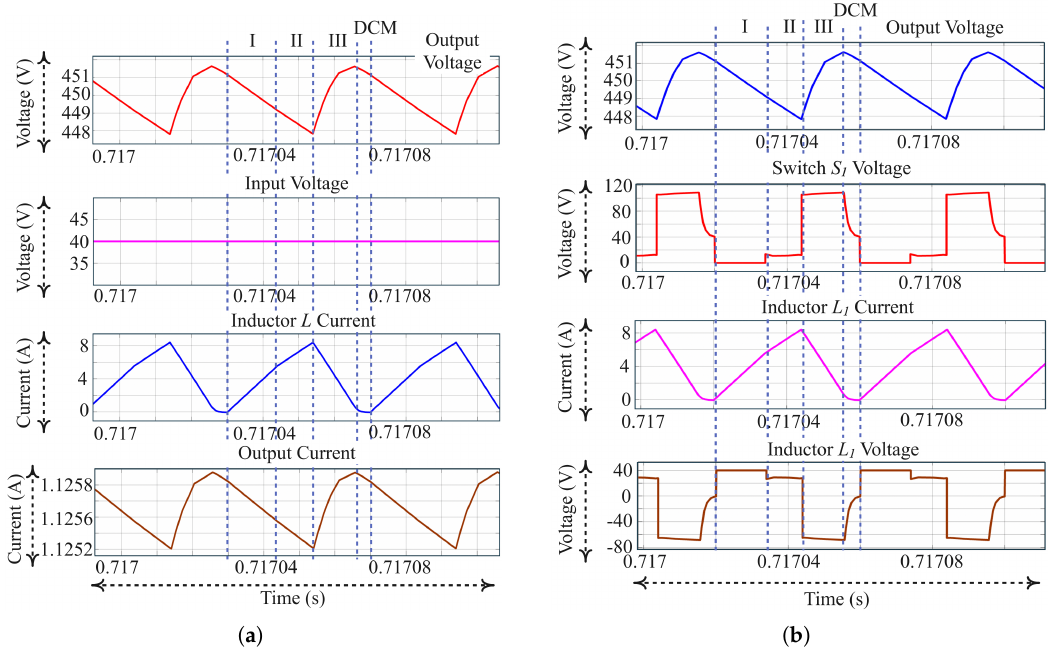
Figure 18. Simulation results in DCM mode, ( a ) v out , v in , i L , and i out ( b ) v out , v S 1 , i L 1 , and v L 1